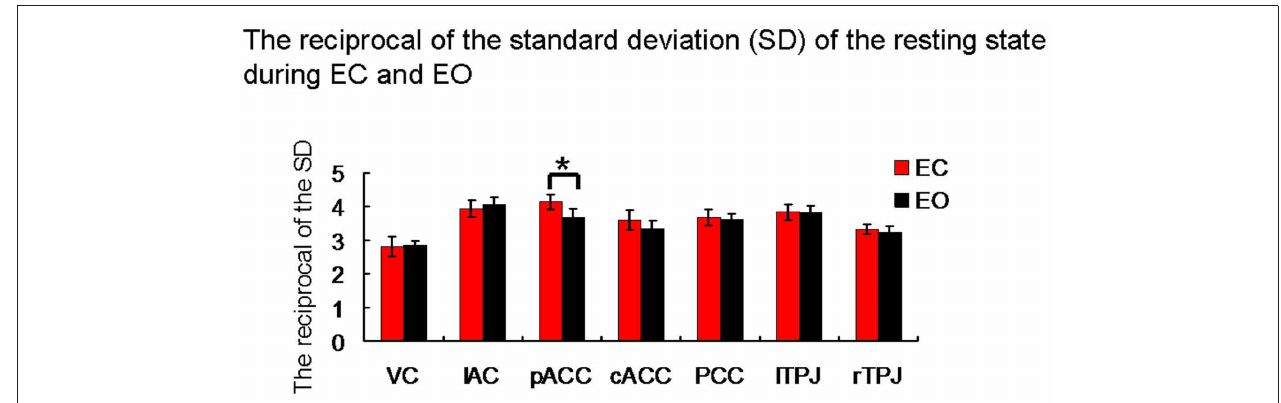
FIGURE 4 | The reciprocal of the standard deviation (SD) of the resting state during both EC and EO. VC, visual cortex; lAC, left auditory cortex; PCC, posterior cingulate cortex; rTPJ, right